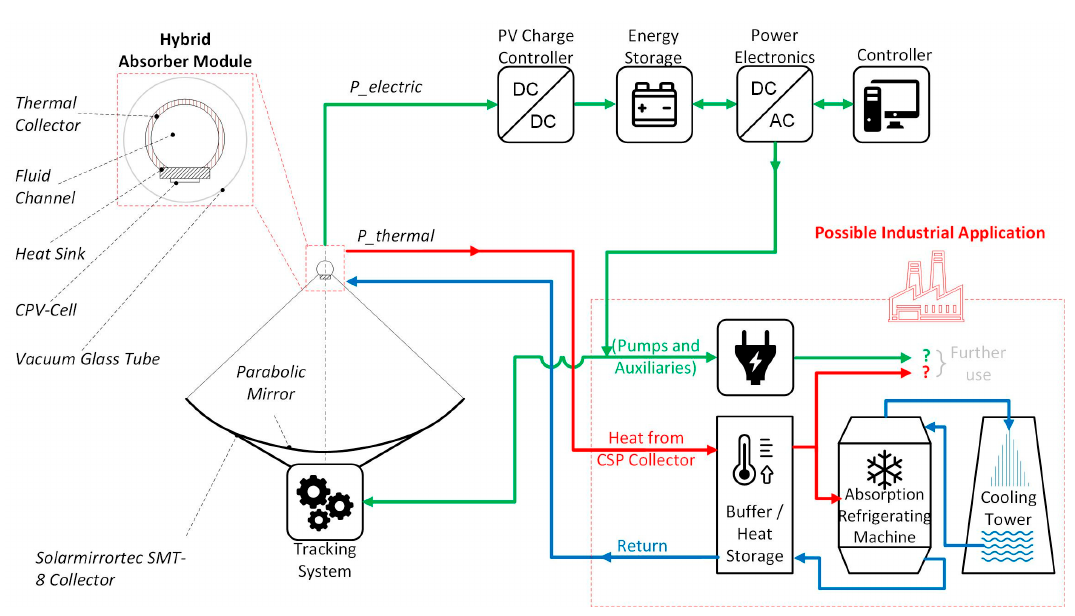
Figure 3. Schematics of solar cooling as a possible industrial application of a CPV-T system involving a parabolic trough collector and